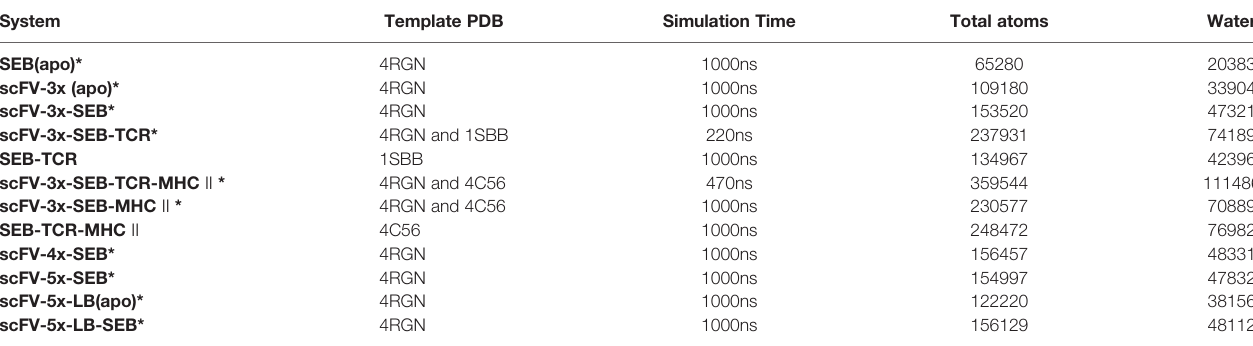
TABLE 1 | Details about the simulated antibody-antigen